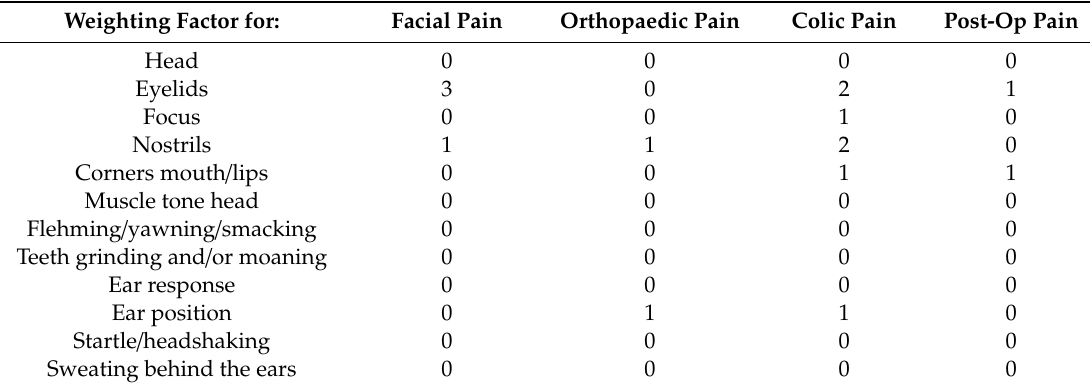
Table 6. Weighting factors of individual parameters of